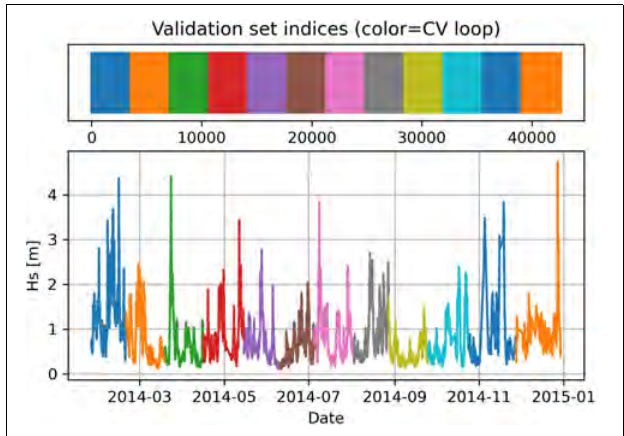
FIGURE 10 | In cross-validation, the full dataset is split in subsets (e.g.,12) of the same size. In this figure, different colors indicate different validation subsets.